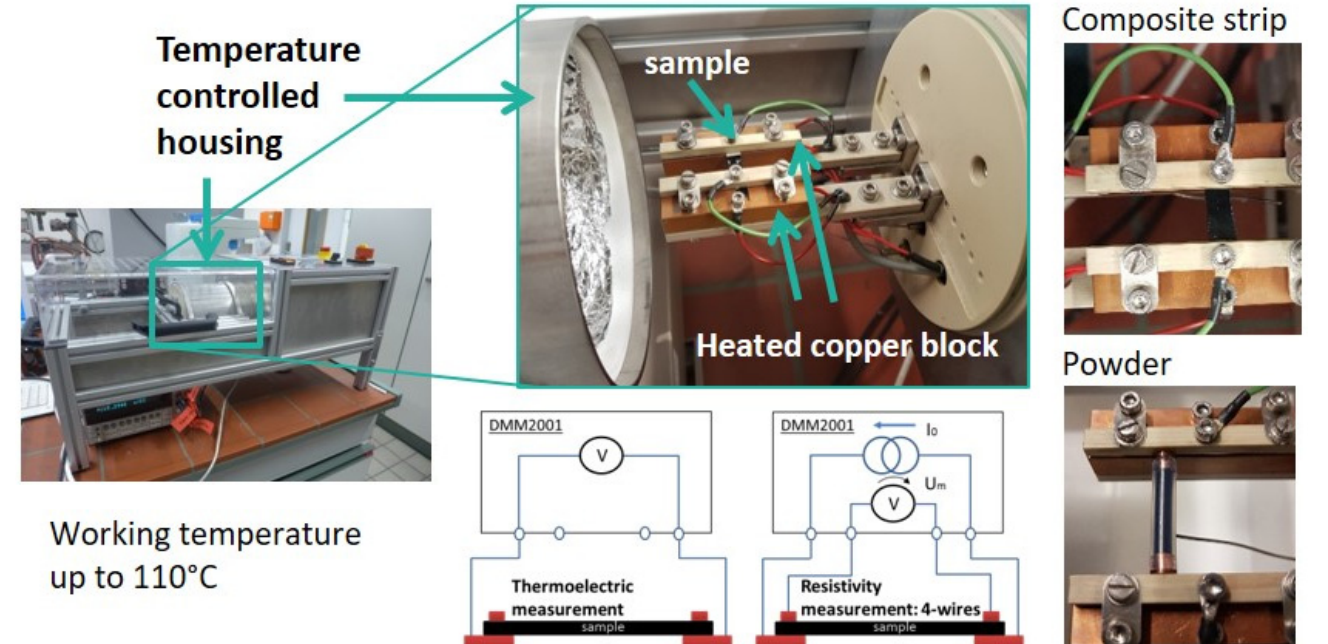
Figure 2. Photos and schema of the used thermoelectric measurement equipment.